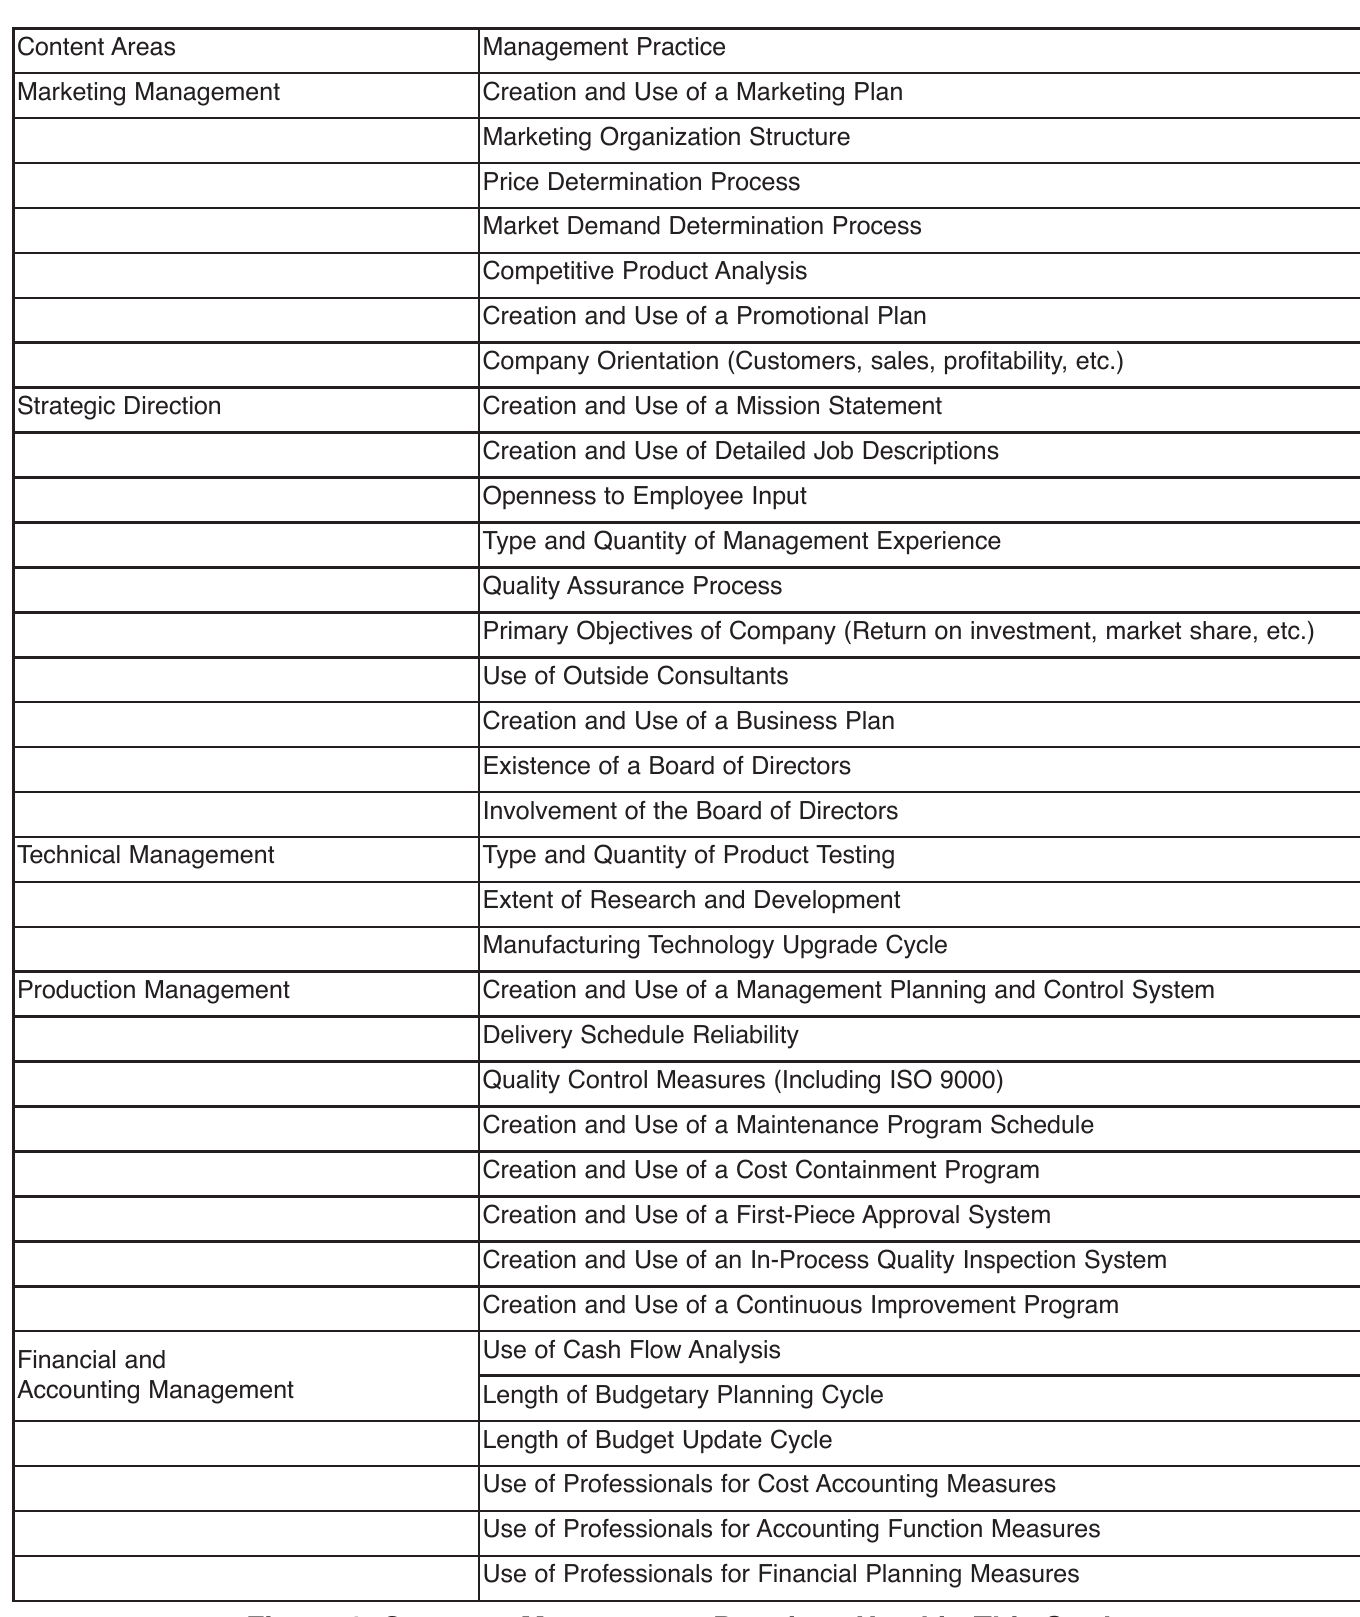
Figure 1. Common Management Practices Used in This